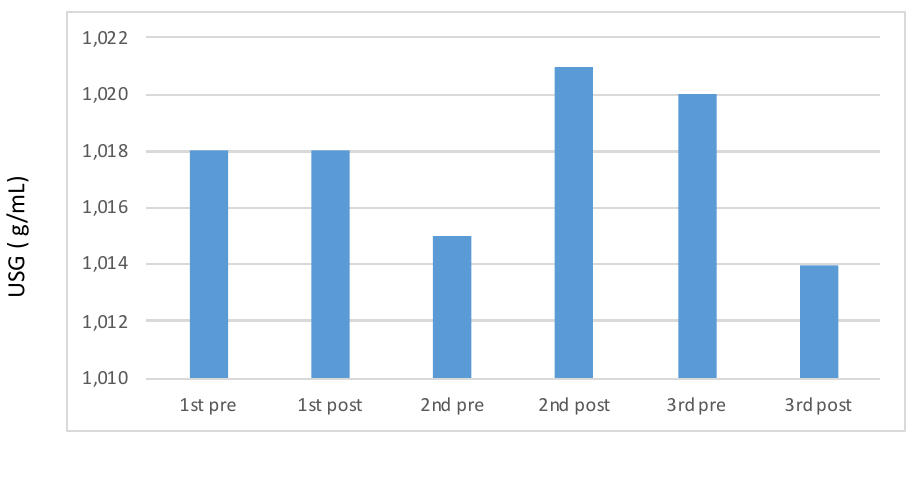
Figure 2. Heart rate responses of female university students before and after each beach handball match